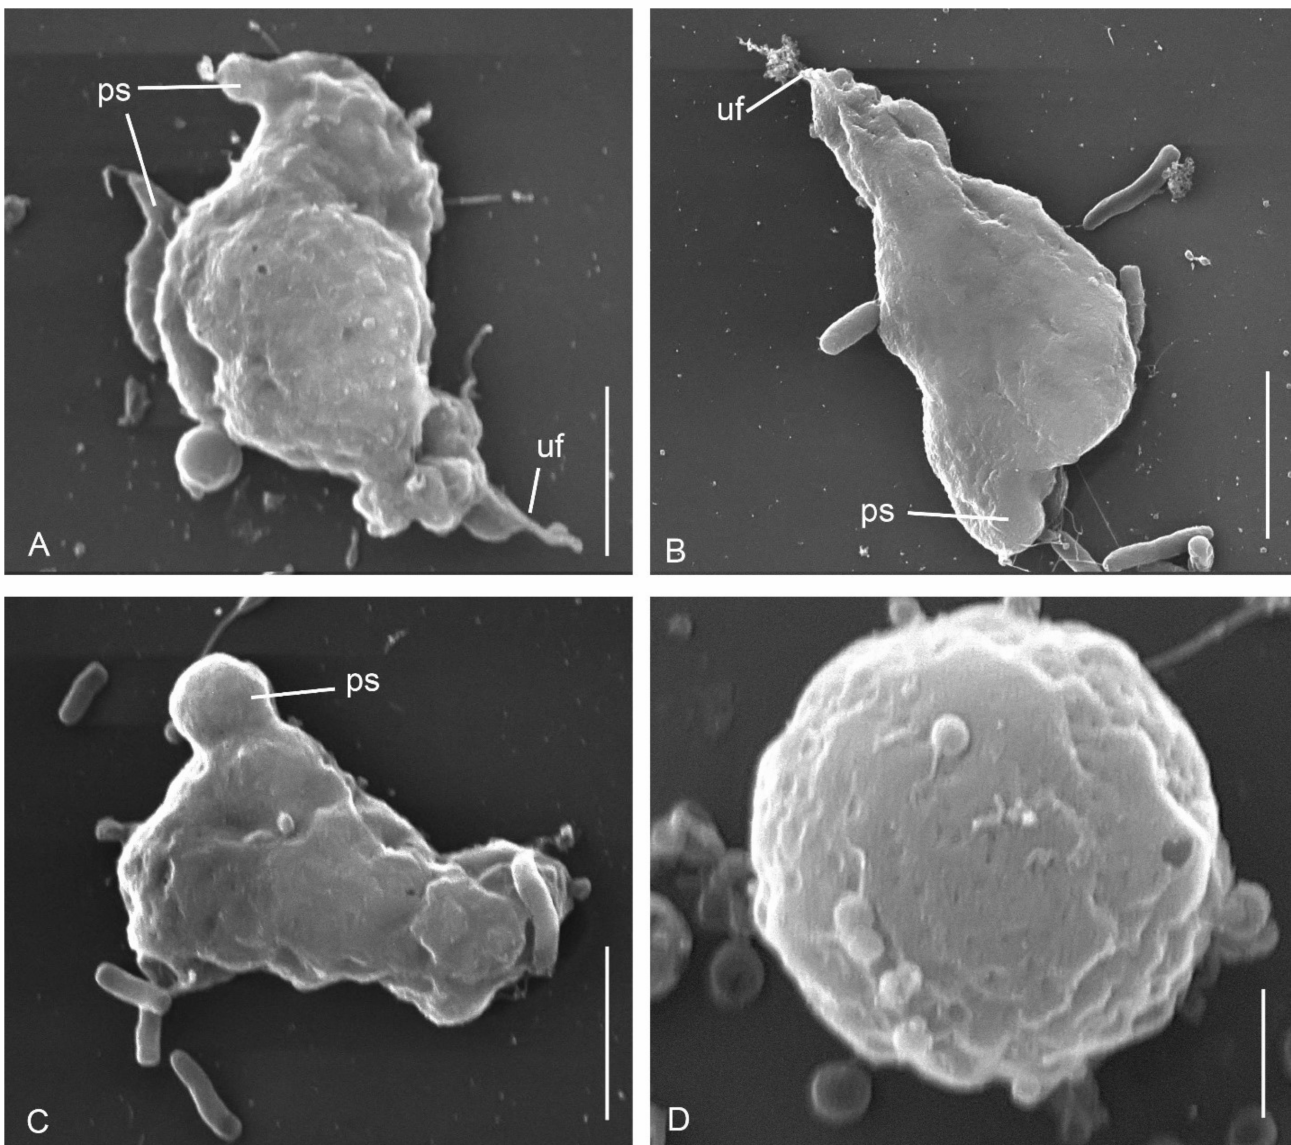
Figure 2. Surface morphology (SEM) of P. stagnalis amoebae ( A – C ) and cyst ( D ). Scale bar: ( A – C )—5 µ m, ( D )—1 µ